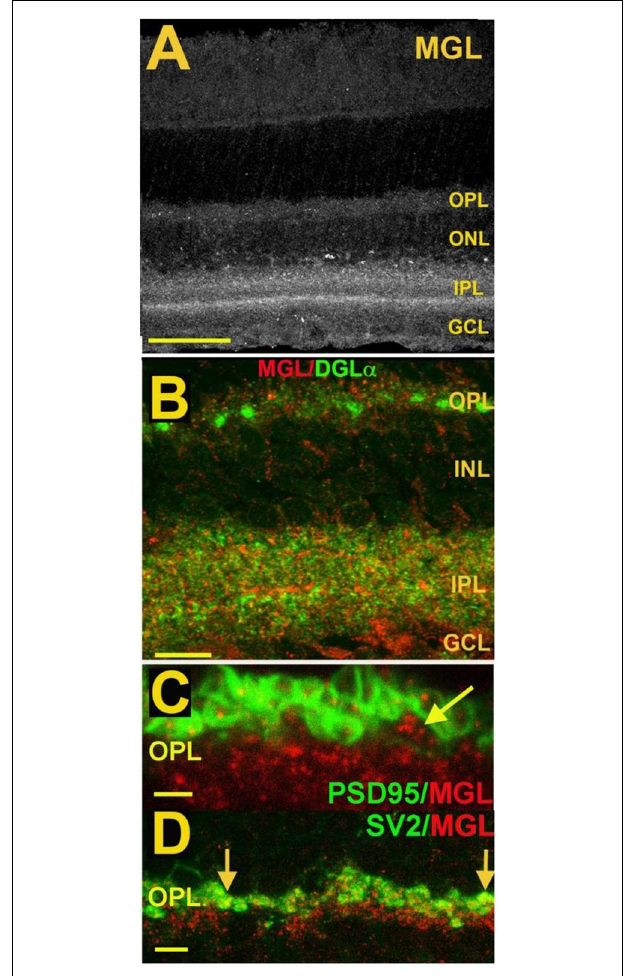
FIGURE 7 | MGL is present in rod spherules and cone pedicles in the OPL and is expressed prominently in two laminae of the IPL. (A) MGL staining in the mouse retina. (B) MGL (red) staining with DGL α (green) shows their apparent non-overlap and relative localization. (C) MGL (red) costaining with PSD95 (green), a marker that outlines rod and cone terminals shows MGL within a cone terminal (arrow) as well as punctate staining within multiple rod spherules. (D) MGL (red) costaining with SV2 (green), a marker for rod spherules, shows substantial overlap in the OPL (arrows). Scale bars: (A) : 60 µ m; (B) : 25 µ m; (C) : 15 µ m; (D) : 25 µ m. Adapted from Hu et al.